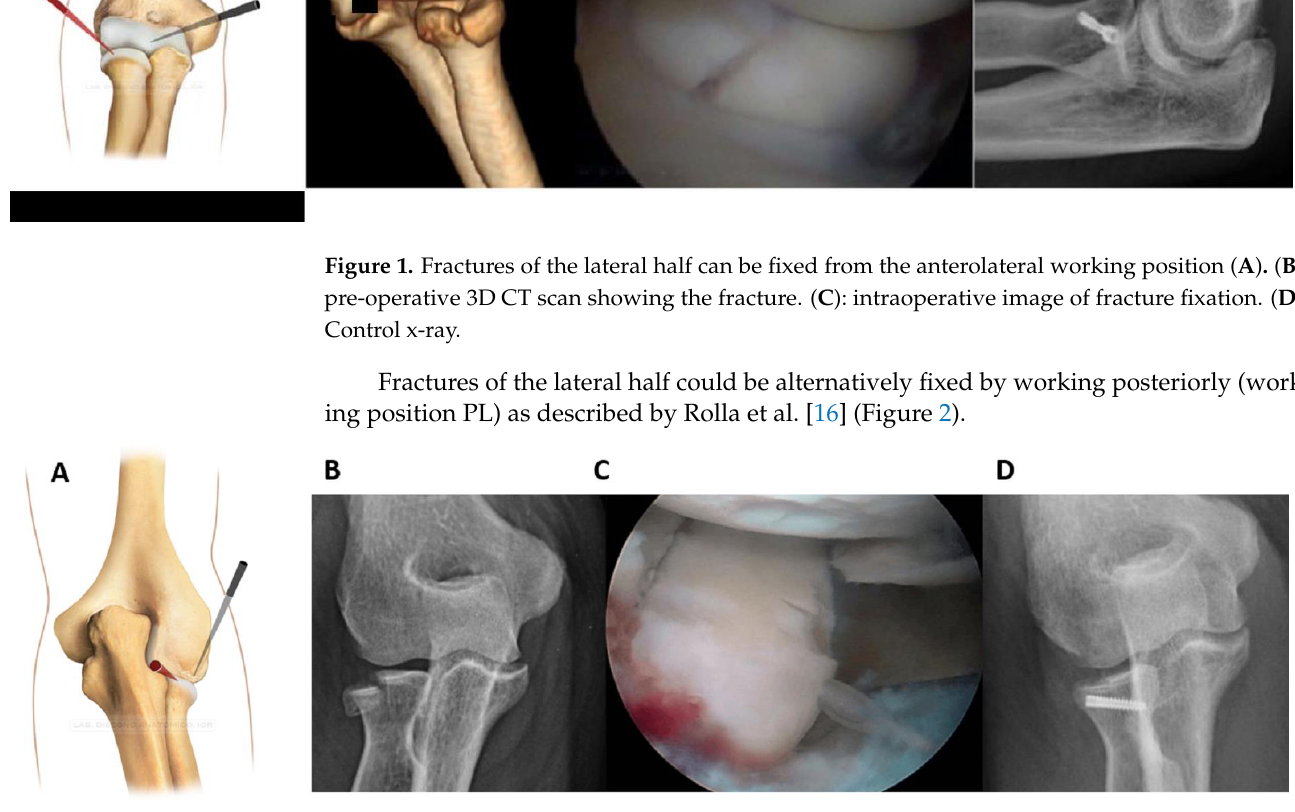
Figure 1. Fractures of the lateral half can be fixed from the anterolateral working position ( A ) . ( B ): pre-operative 3D CT scan showing the fracture. ( C ): intraoperative image of fracture fixation. ( D ): Control x-ray.